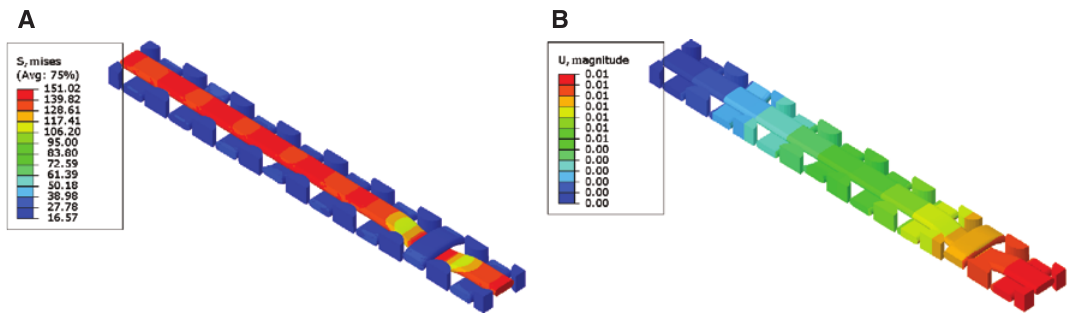
Figure 13: Stress and displacement nephograms of ORUC under unidirectional tensile loading ε (A) Mises stress nephogram. (B) Magnitude displacement